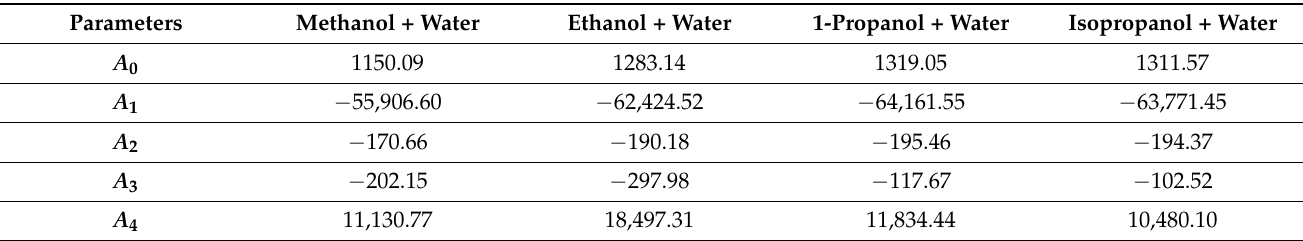
Table 7. Model parameters of Jouyban–Acree model for molar ratio solubility of florfenicol in binary